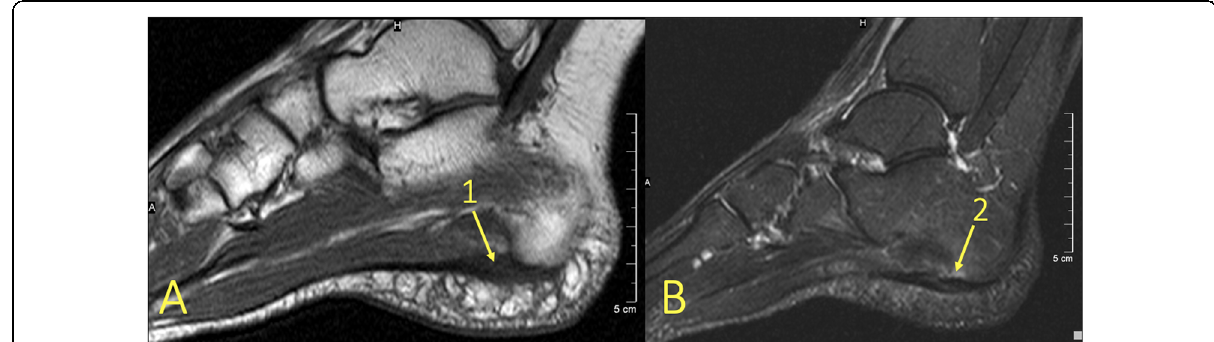
Fig. 12 A 43-year-old female with chronic pain in the plantar part of the heel and suspicion of a heel spur and plantar aponeurosis rupture. MRI revealed (1) enthesopathy of the plantar fascia with (2) bone marrow edema in the